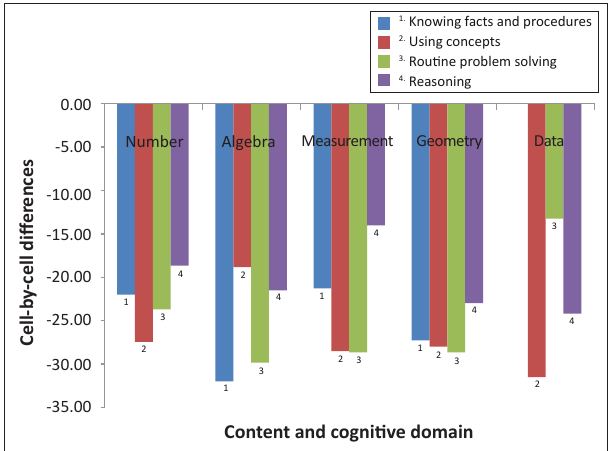
FIGURE 5: South African students’ performance by content and cognitive domains in TIMSS 2003 compared to the international TABLE 11: Comparison of RNCS-TIMSS discrepancy with SA performance in TIMSS 2003. Cognitive domain